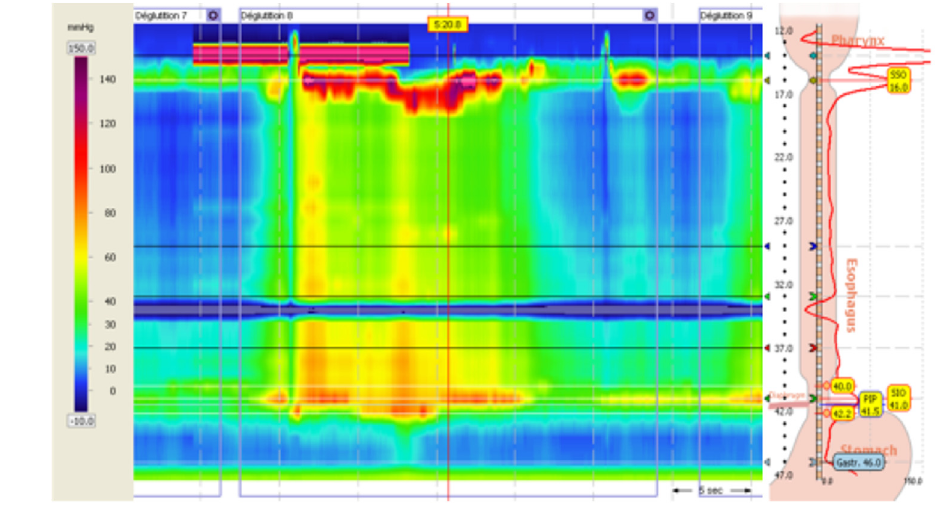
Figure 2. Esophageal high-resolution